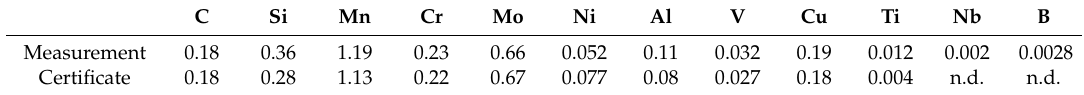
Table 1. Chemical composition of used steel S960QL; wt [%].